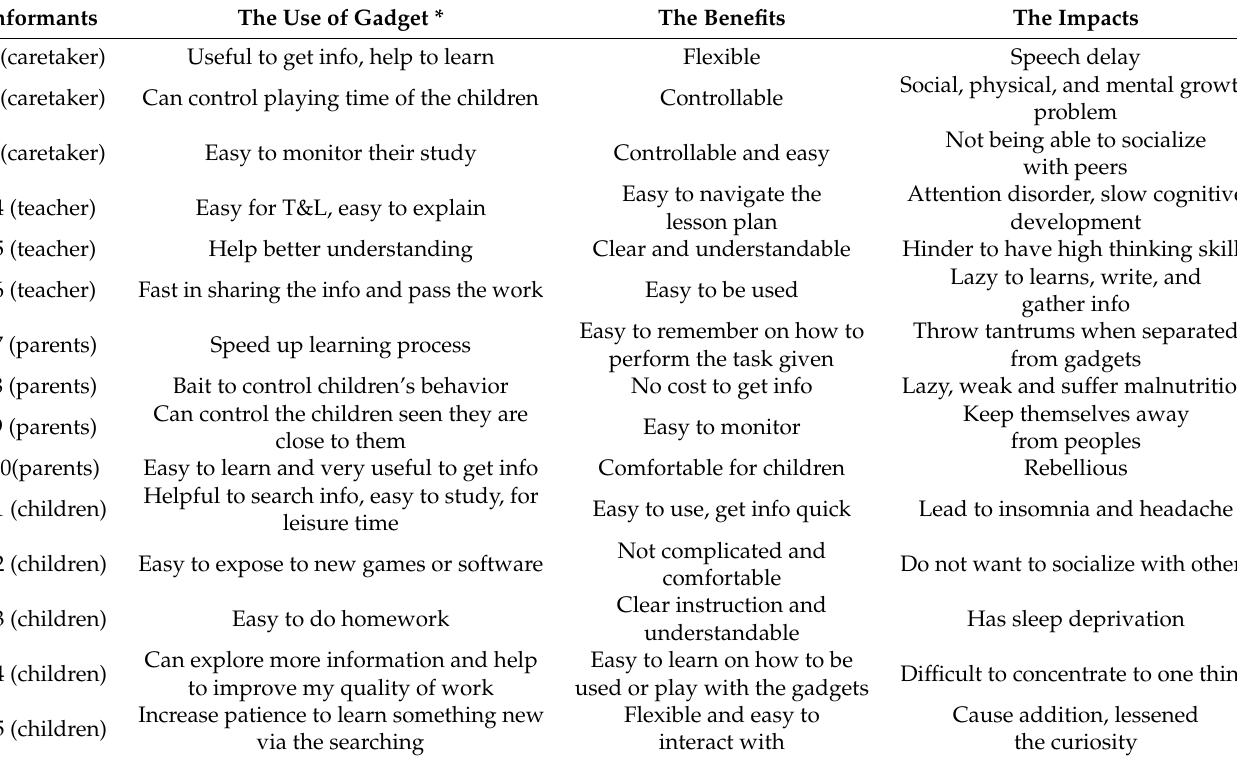
Table 1. The use and the impacts on gadget among the children.